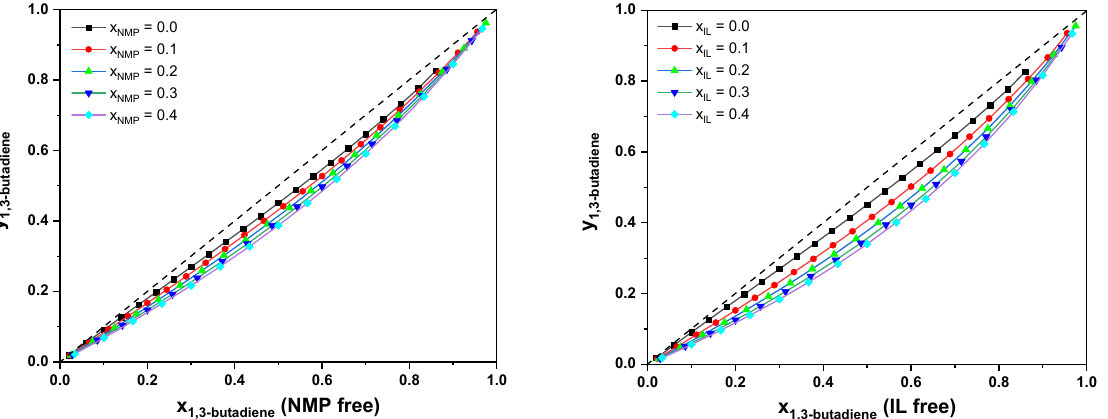
Figure 10. Vapor–liquid phase diagrams of {butadiene-butene-NMP} ( left ) and {butadiene-butene- [PMIM][MCO]} ( right ) at 298.15 K.